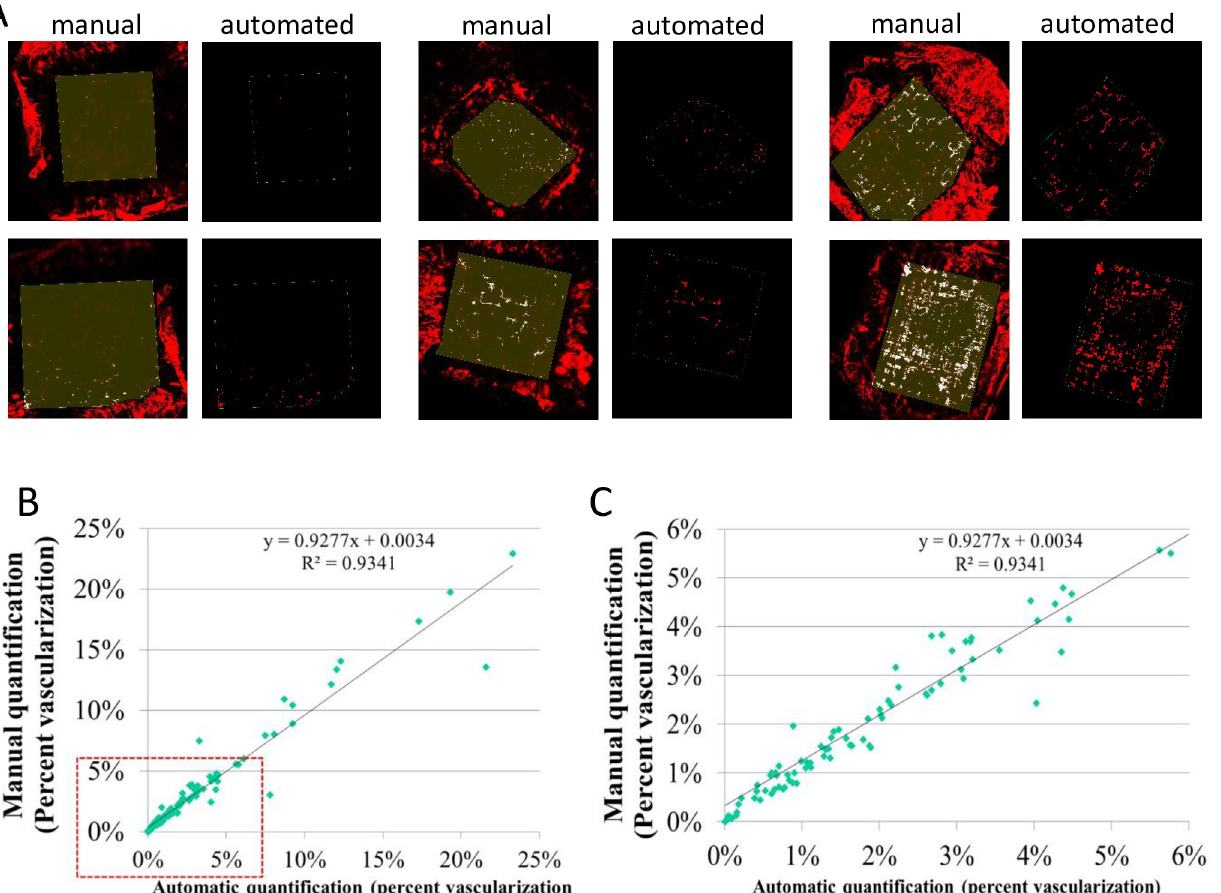
Fig 2. Comparison of manual quantification vs. automated quantification. (A) Images from manual quantification are shown (left) with their corresponding images from the automated quantification (right) for 6 samples representative of low, medium, and high levels of NV. Note that in the images from the automated quantifications, vessels outside of the upper mesh area of the onplant are not displayed as a feature of the software. (B—C) Comparison of 100 quantified images using the manual vs. automated computational methods demonstrates strong correlation throughout the range of onplant vascularization (B), as well as a comparison of the percent of vascularization for lower levels of vascularization (below 6%) (C).